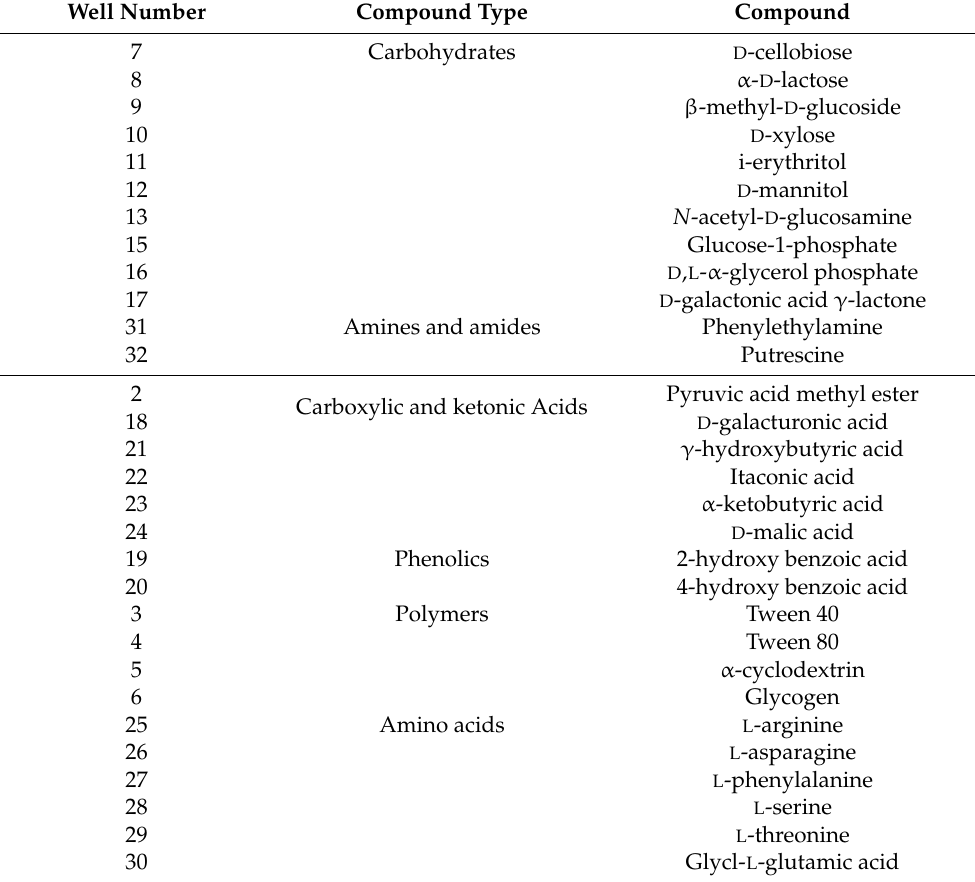
Table 2. Carbon substrates represented on EcoPlates TM